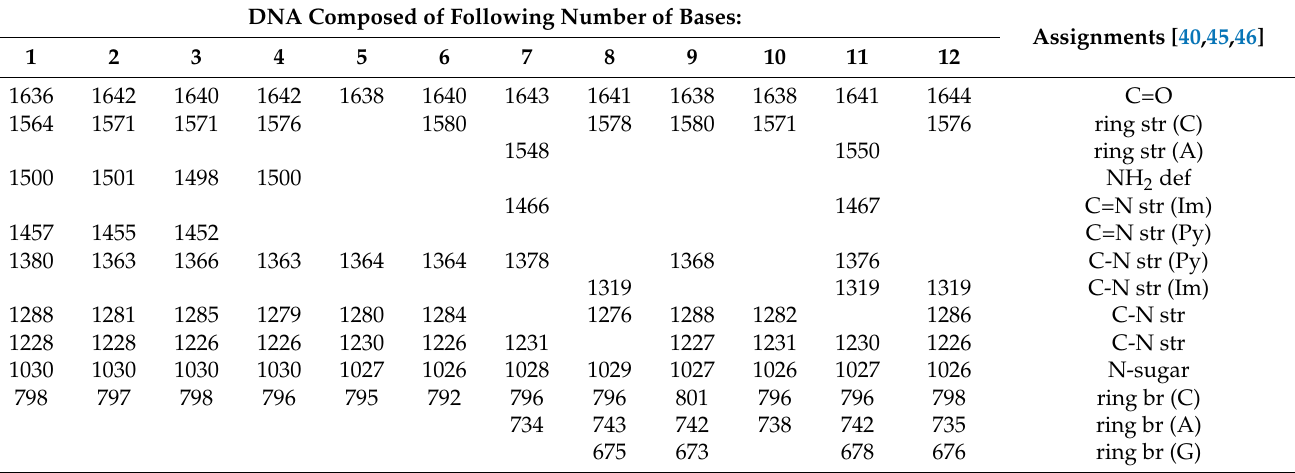
Table 1. Assignments of the most intense Raman bands appearing in the SERS spectra of various thiolated DNA adsorbed on gold nanoparticles deposited using a freezing step. The numbers from 1 to 12 refer to the DNA chain length. DNA Composed of Following Number of